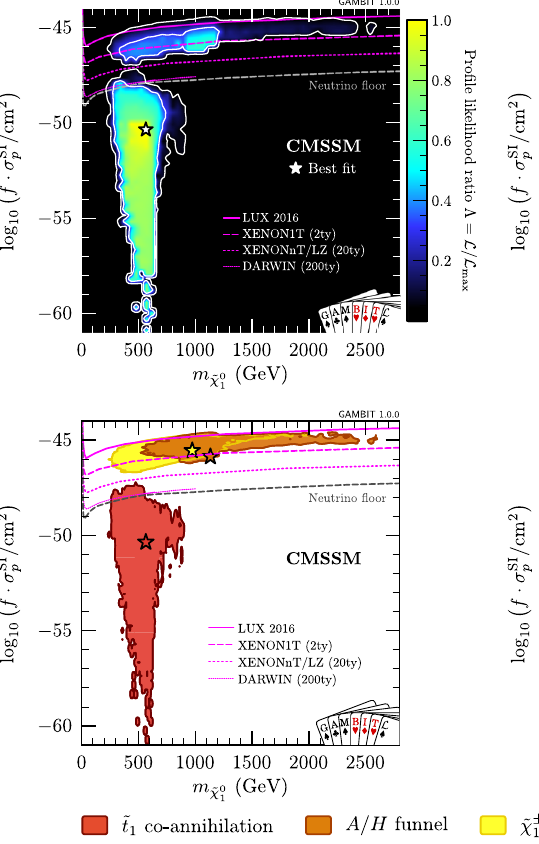
Fig. 19 The spin-independent neutralino-proton cross-section. Upper left:ProfilelikelihoodintheCMSSM.Lowerleft:Colour-codingshows the active mechanism(s) by which CMSSM models avoid exceed- ing the observed relic density of DM, through either chargino co- annihilation,the A / H funnel,orstopco-annihilation.Topright:Colour- coded regions in the NUHM1, now also featuring stau co-annihilation (blue). Bottom right: Colour-coded regions of the NUHM2. 90% CL exclusion limits are overlaid from the complete LUX exposure [228],